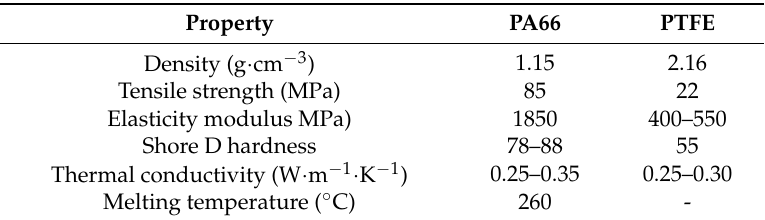
Table 1. Major properties of the studied